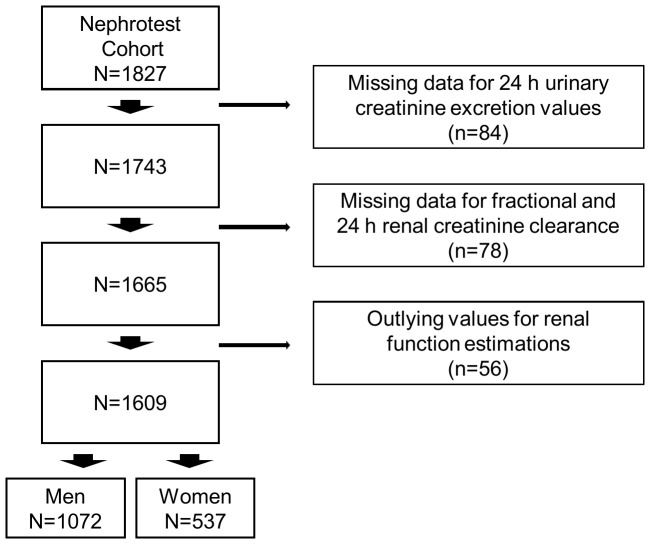
Flowchart of study sample.